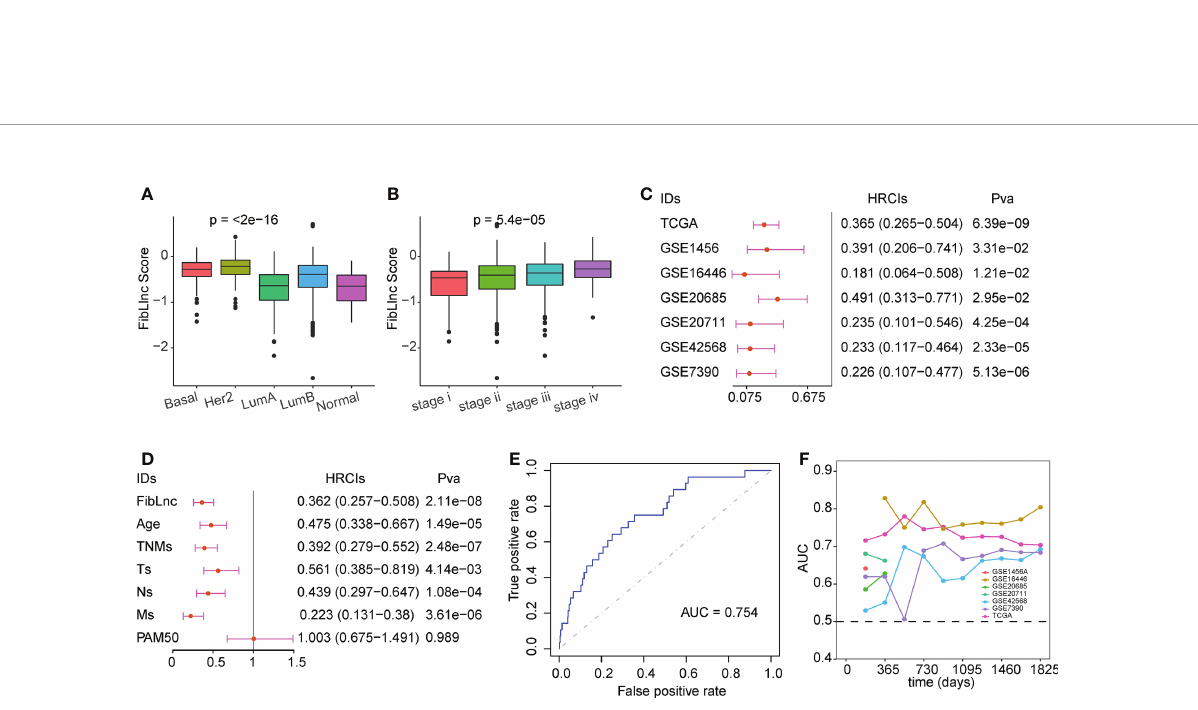
FIGURE 3 Evaluation for the prognostic value of the FibLnc score. (A) Analysis of the differences in the distribution of FibLnc scores among different PAM50 subtypes. (B) Analysis of the differences in the distribution of FibLnc scores among different TNM stages. (C) Forest plot of Cox analysis in TCGA and Gene Expression Omnibus (GEO) datasets. (D) Forest plot of Cox analysis of the FibLnc score and clinical features. (E) ROC curve of FibLnc scores used for survival status prediction. (F) Time-dependent area-under-the-curve value in TCGA, GSE1456, GSE7390, GSE16446, GSE20685, GSE20711, and